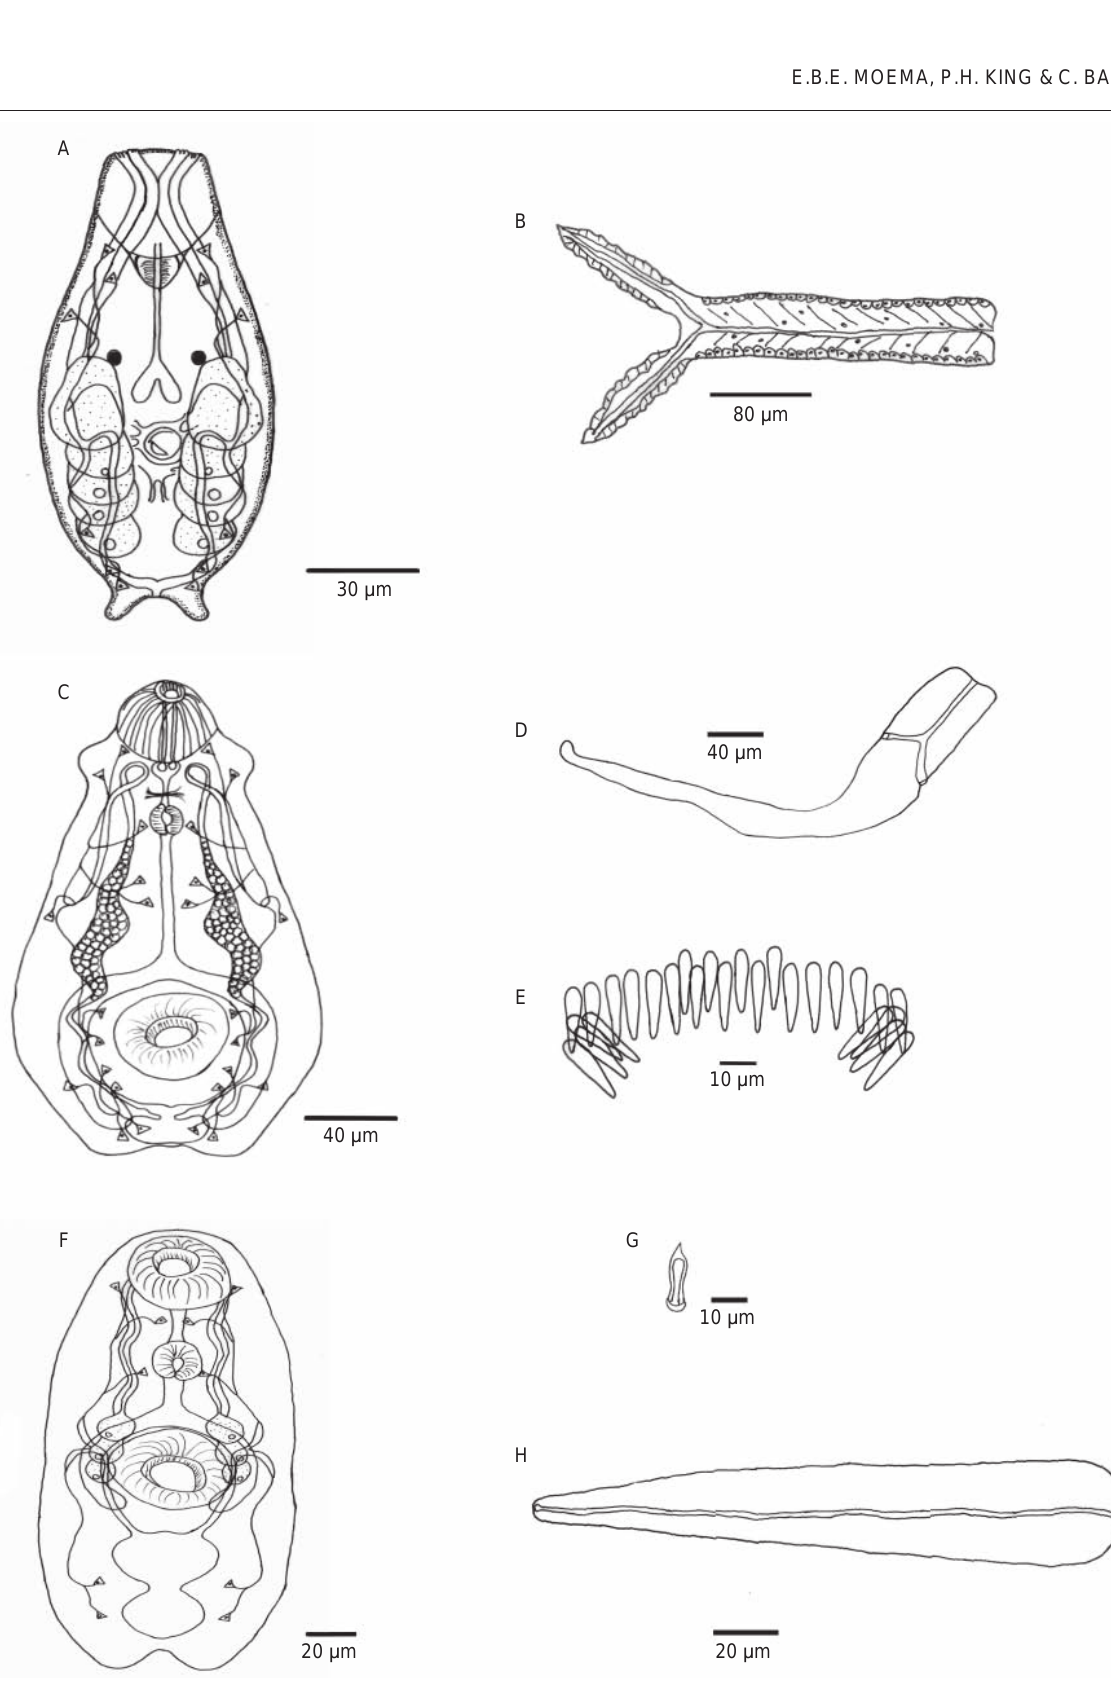
FIG. 1 Light microscope projection drawings of three types of cercariae shed by Lymnaea natalensis : an apharyngeal-brevifurcate distiome cercaria (A) head and (B) forked tail; an echinostomatid cercaria (C) head, (D) single tail and (E) collar spines; and a xiphidio cercaria (F) head, (G) stylet and (H) single